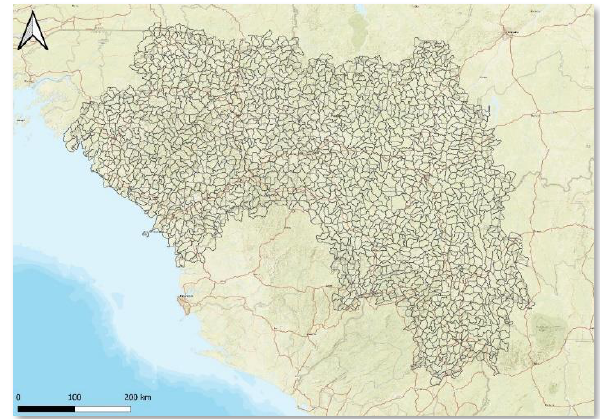
Figure 3. SELU cover the Républic of Guinea (HydroBASINS, Lehner & Grill, 2013) Examples include watershed data available in HydroBASINS or river maps obtained from